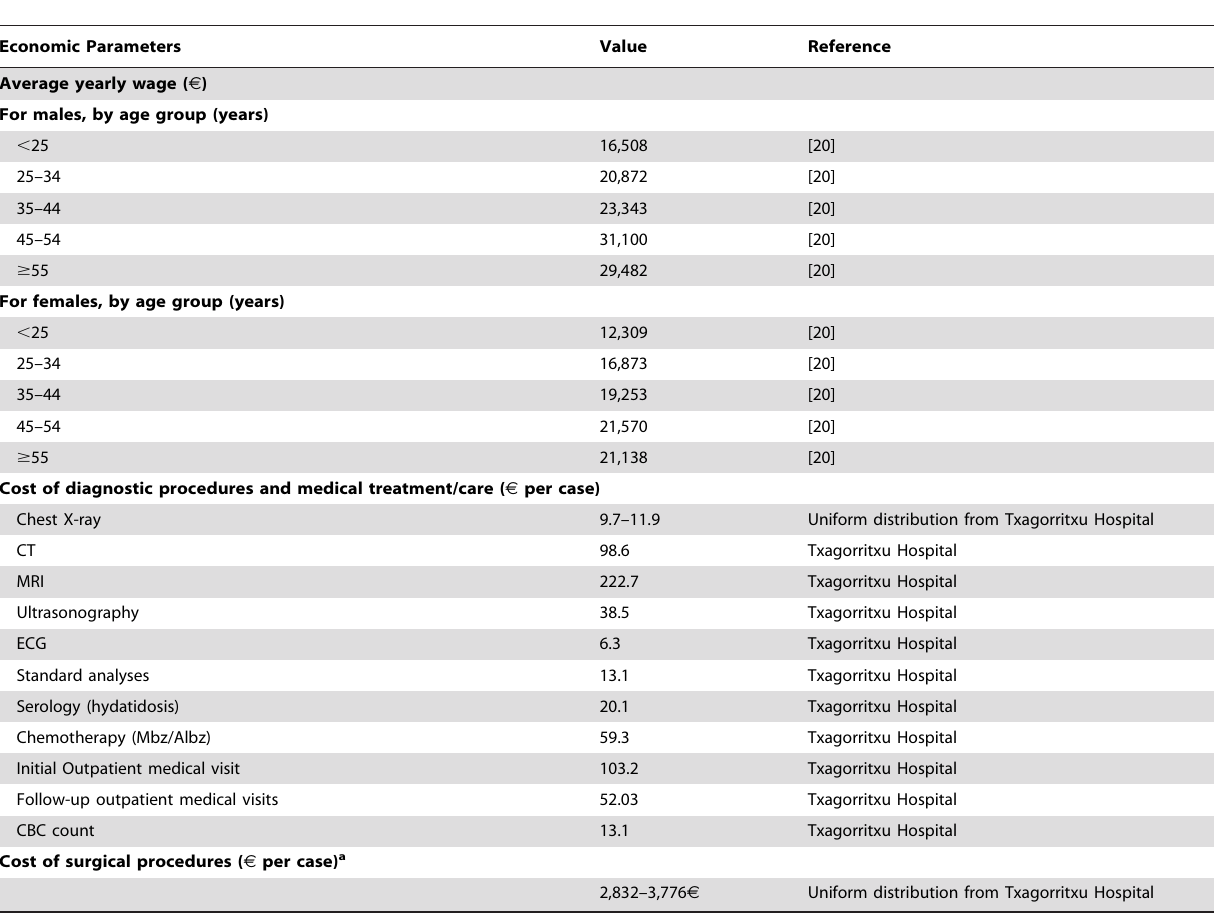
Table 3. Age-gender stratified wages in the Basque Country in 2005 and costs of treatment and diagnostic test to treat CE patients in A´lava,